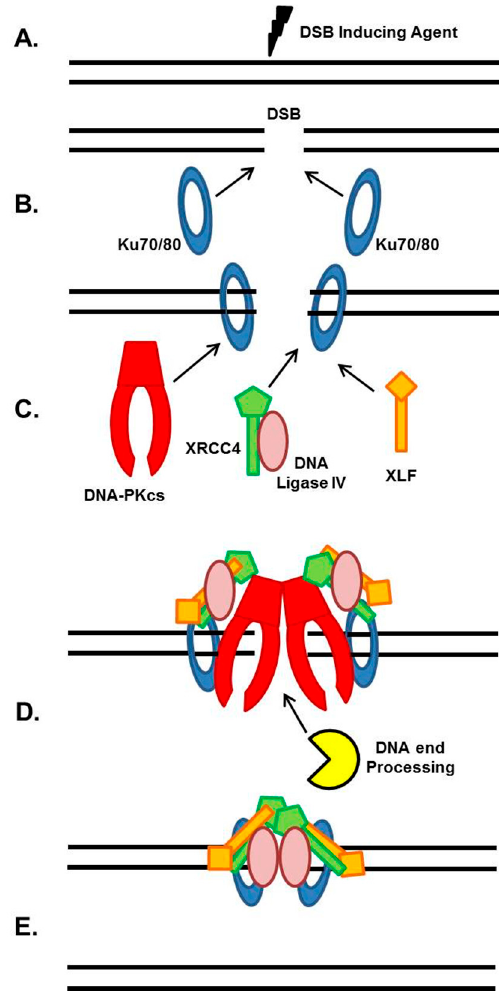
Figure 1. General NHEJ Mechanism. ( A ) and ( B ). A DNA double strand break (DSB) is induced and is quickly bound by the Ku heterodimer; ( C ). Ku70/80 serves as a scaffold to recruit the NHEJ machinery to the DSB; ( D ). If the DSB ends cannot be ligated, they will be processed by specific DNA end processing factors; ( E ). The DSB is ligated by DNA Ligase IV and NHEJ is complete.